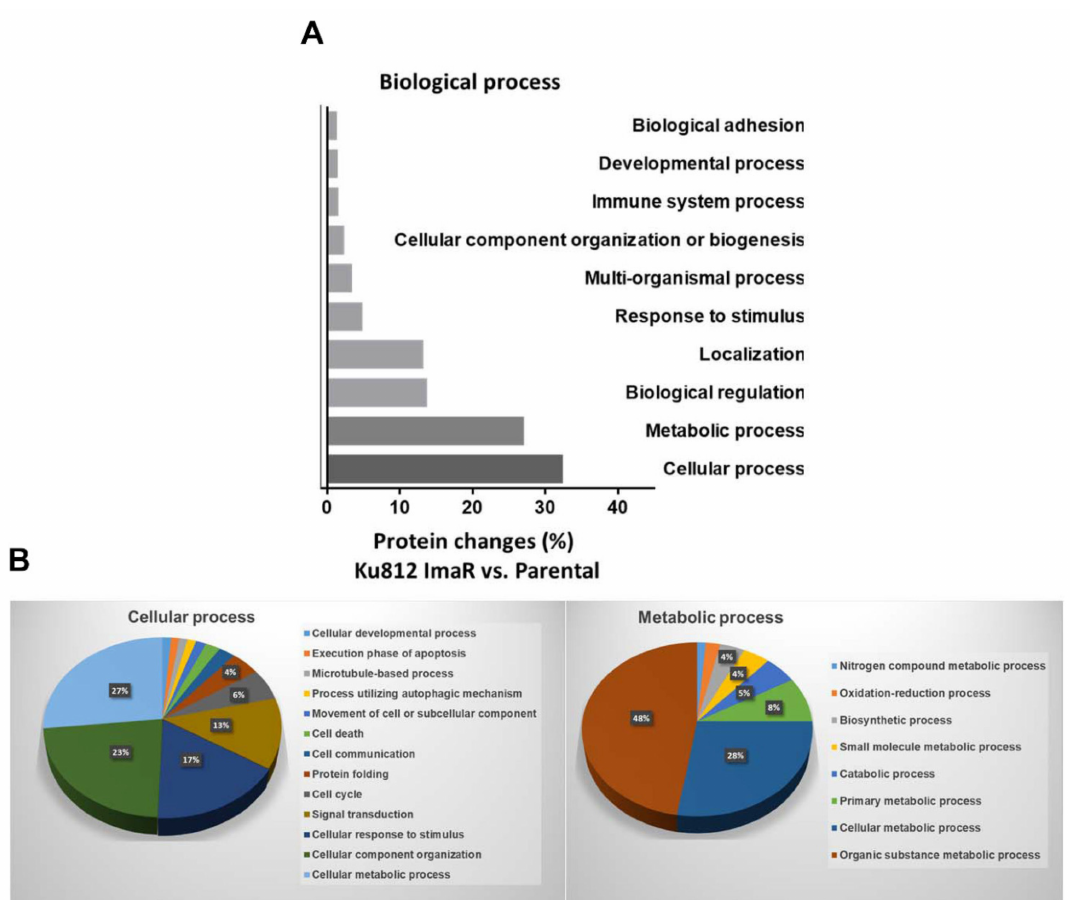
Figure 2. Pathway analysis of di ff erentially expressed proteins identified by SILAC-based proteomics analysis of KU812 ImaR vs. KU812 P under normoxia. Only biological process whose contribution is > 1% appear in the plot. Data are provided as mean ± SD of n = 2. ( A ) The bar chart shows biological processes enrichment analysis, based on the PANTHER gene ontology classification system. The up / down regulated proteins threshold for the analysis was defined as log 2 fold change ≥